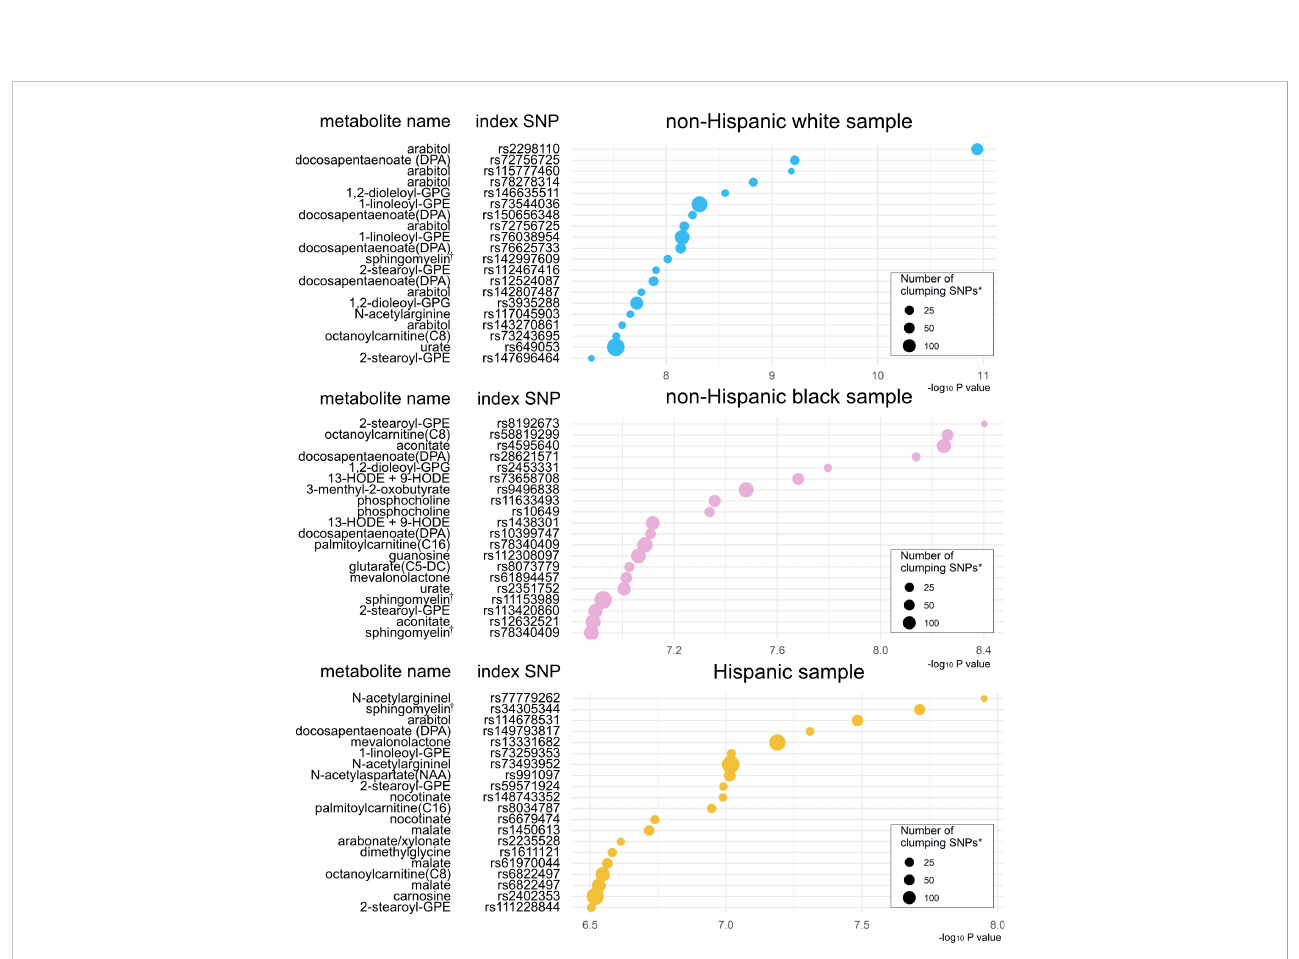
FIGURE 3 Signi fi cant index SNPs identi fi ed in metabolite quantitative trait loci (mtQTL) analyses The 20 index SNPs with the lowest P-values associated with the candidate metabolites were identi fi ed in the mtQTL analysis of each racial/ethnic sample after the clumping procedure. * Variants with a Pvalue of <1×10 − 3 , R 2 of ≥ 0.2, and <500kb away from the index SNP were assigned to the clump. † Sphingomyelin (d17:1/16:0, d18:1/15:0, d16:1/17:0) Abbreviations: GPE, glycerophosphorylethanolamine; GPG, glycero-3-phosphoglycerol; HODE, hydroxyoctadecadienoic